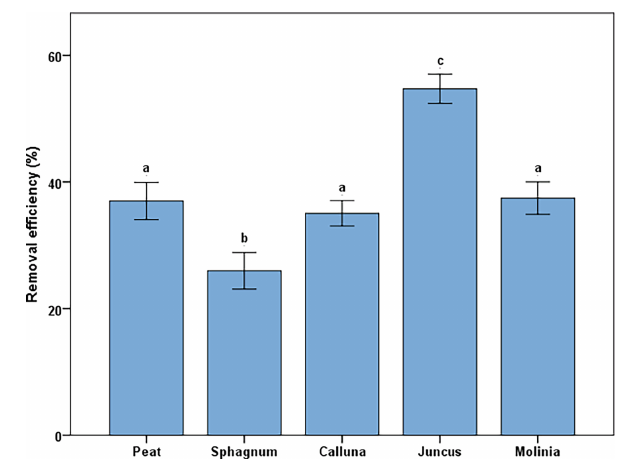
Figure 3. SUVA value of Molinia caerulea -derived DOC produced under differing severities of drought ( n = 5 per treatment) with error bars at 1 standard error. Letters indicate statistically similar groups from the Tukey test.